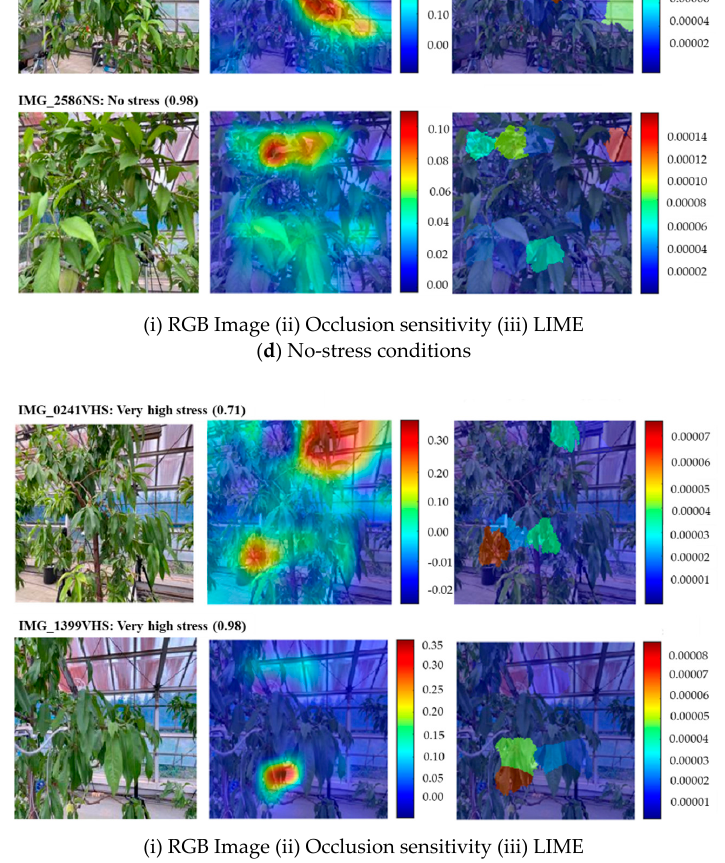
Figure 14. Visualization of the HortNet417v1 network decision behind the prediction of classification of the peach plant stress condition.